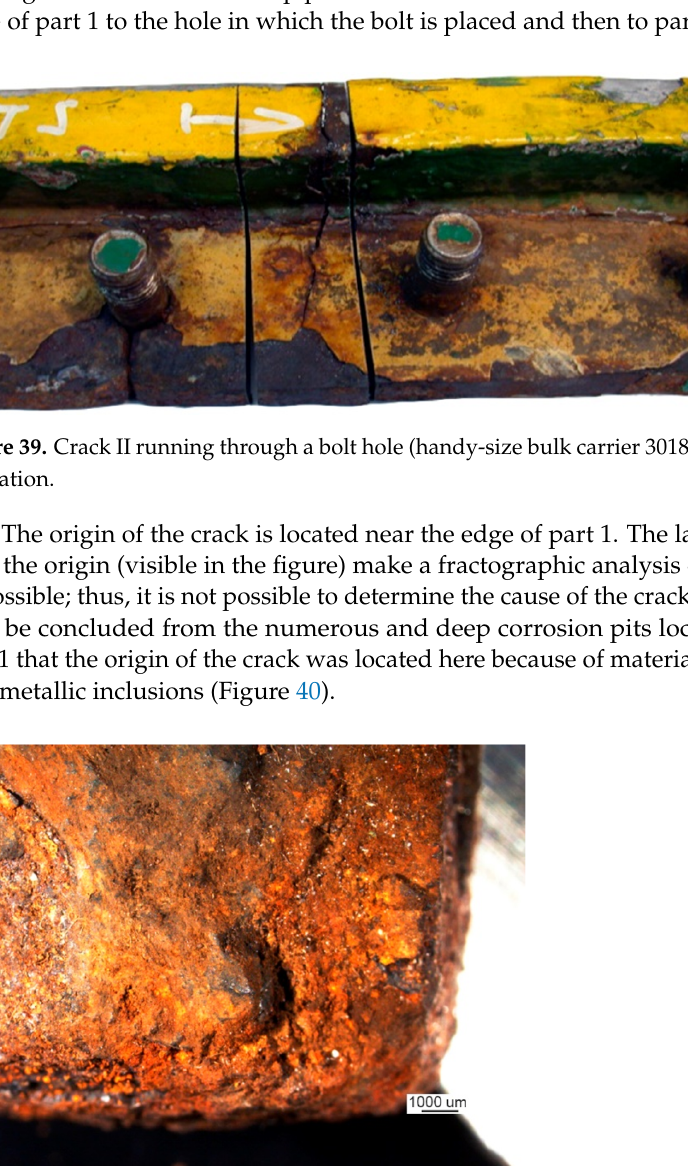
Figure 40. Corrosion pits at the edge of part 1 (handy-size bulk carrier 30185 DWT). Stereoscopic optical